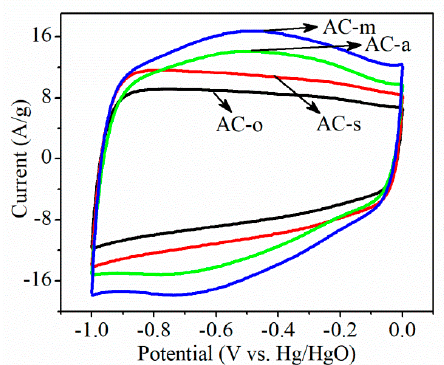
Figure 4. Cyclic voltammetry (CV) curves of the samples at the scan rate of 100 mV/s.